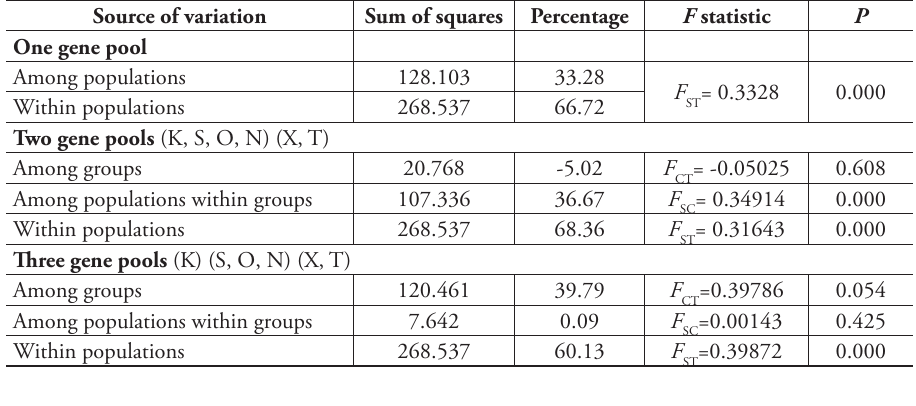
Table 4. AMOVA of P. argenteus populations based on mitochondrial CR sequences.